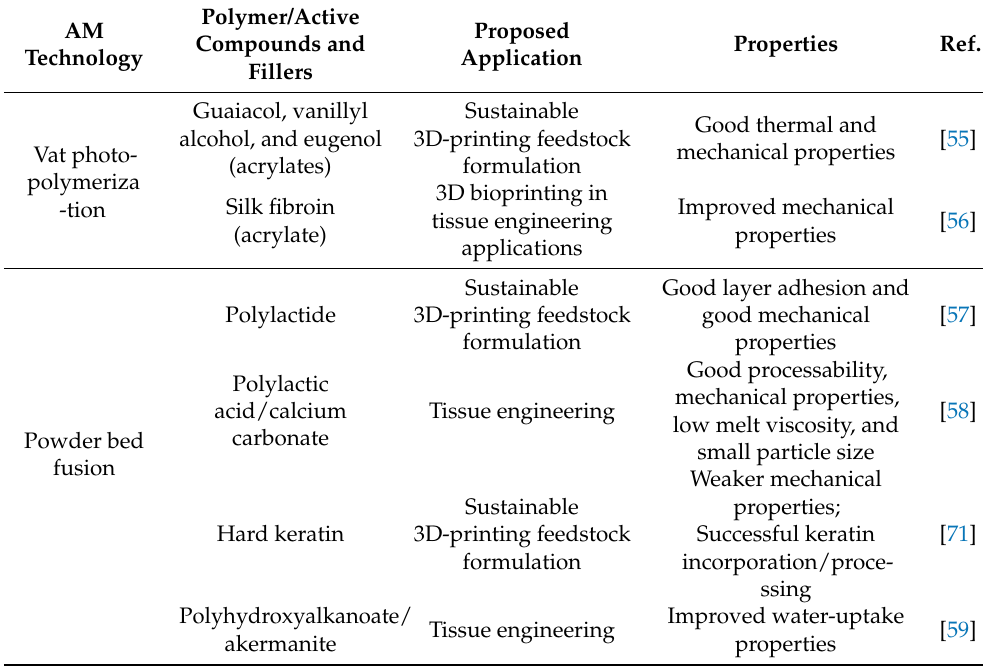
Table 3. Studies on 3D printing with biopolymers of relevance to the food